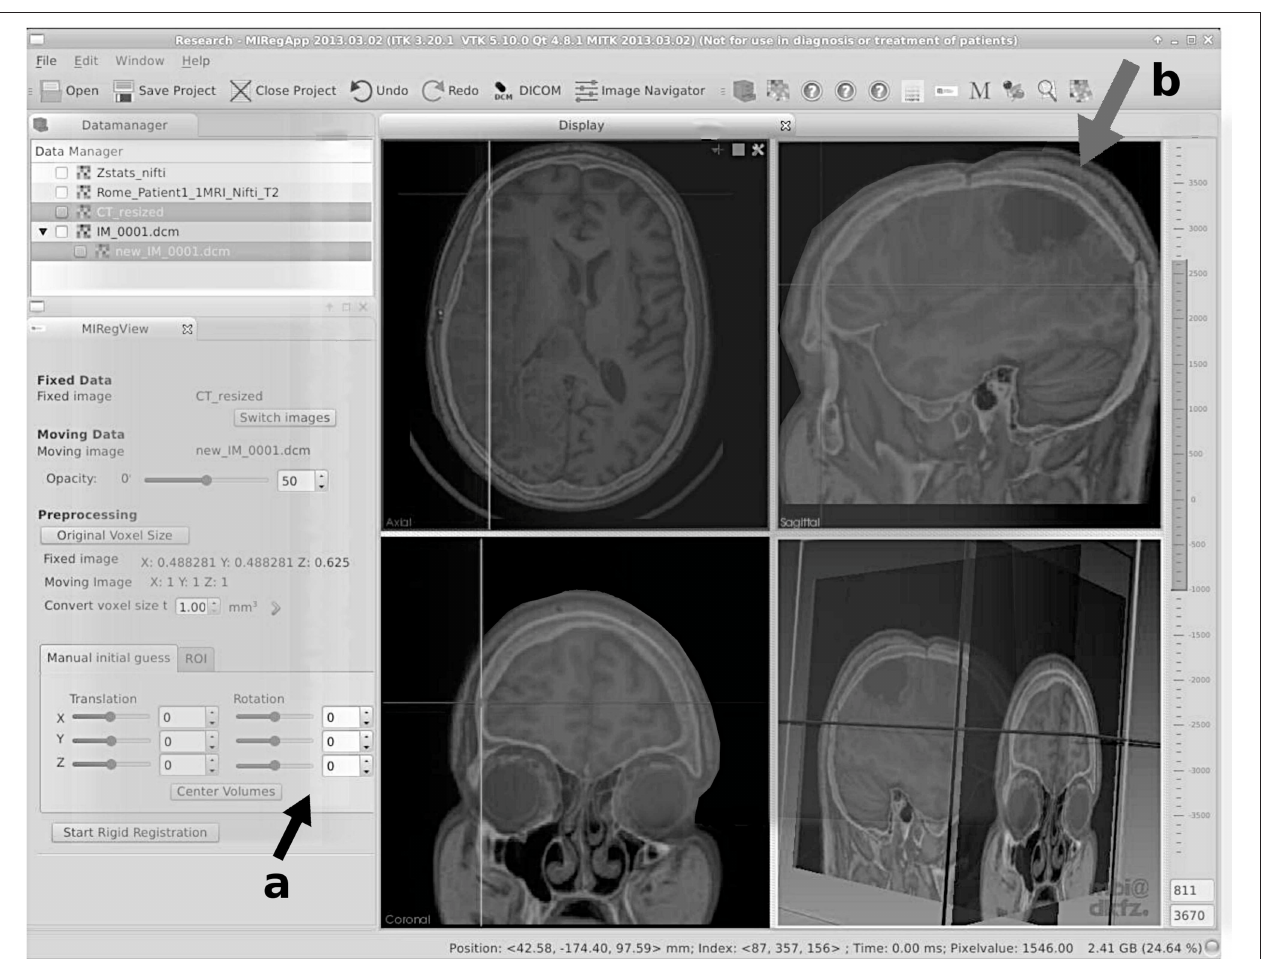
FIGURE 4 | User interface of a modern research grade image fusion software for merging CT and MRI data using normalized mutual information. Here, a fusion of CT and T2-weighted MRI of a neurological case is shown. Aside from rough manual positioning (see the user interface elements, indicated with arrow a), the process is automatic. In this case, a neurological tumor is seen in the upper right fused image (indicated by arrow b). Deformation due to a neurosurgical intervention is obvious, still the algorithm is capable of coping with these deviations for this case of rigid registration. This software was developed in the course of FP7-PEOPLE-2011-ITN “SUMMER—Software for the Use of Multi-Modality images in External Radiotherapy” funded by the European Commission. More details on the software are provided in Aselmaa et al. [